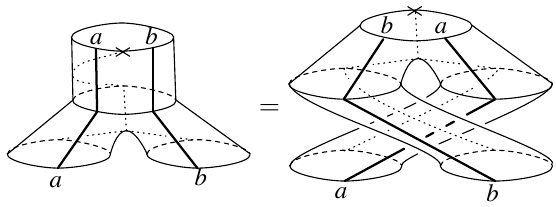
Figure 44 . I is a unit of the product M a; 1 .